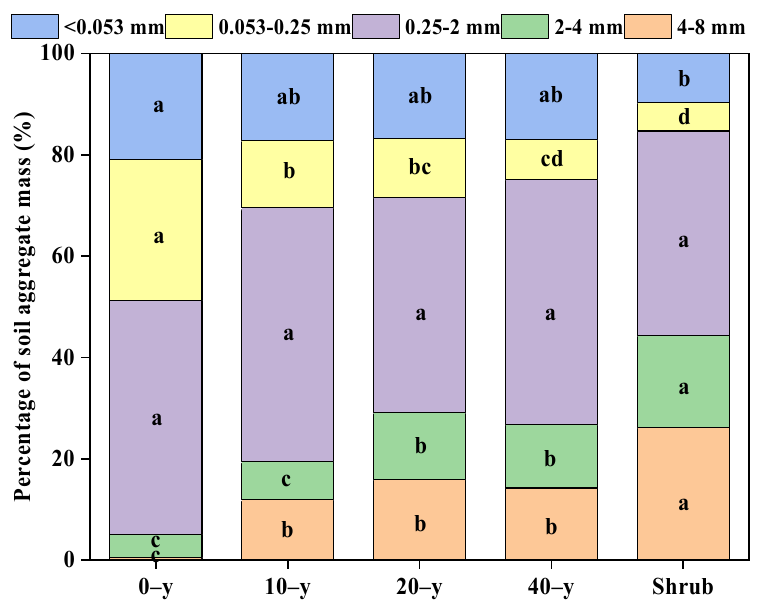
Figure 2. The size distribution of soil aggregates. Different lowercase letters indicate that soil aggregates with the same size reached the significance level of 0.05 between different afforestation years of D. viscosa and shrub.